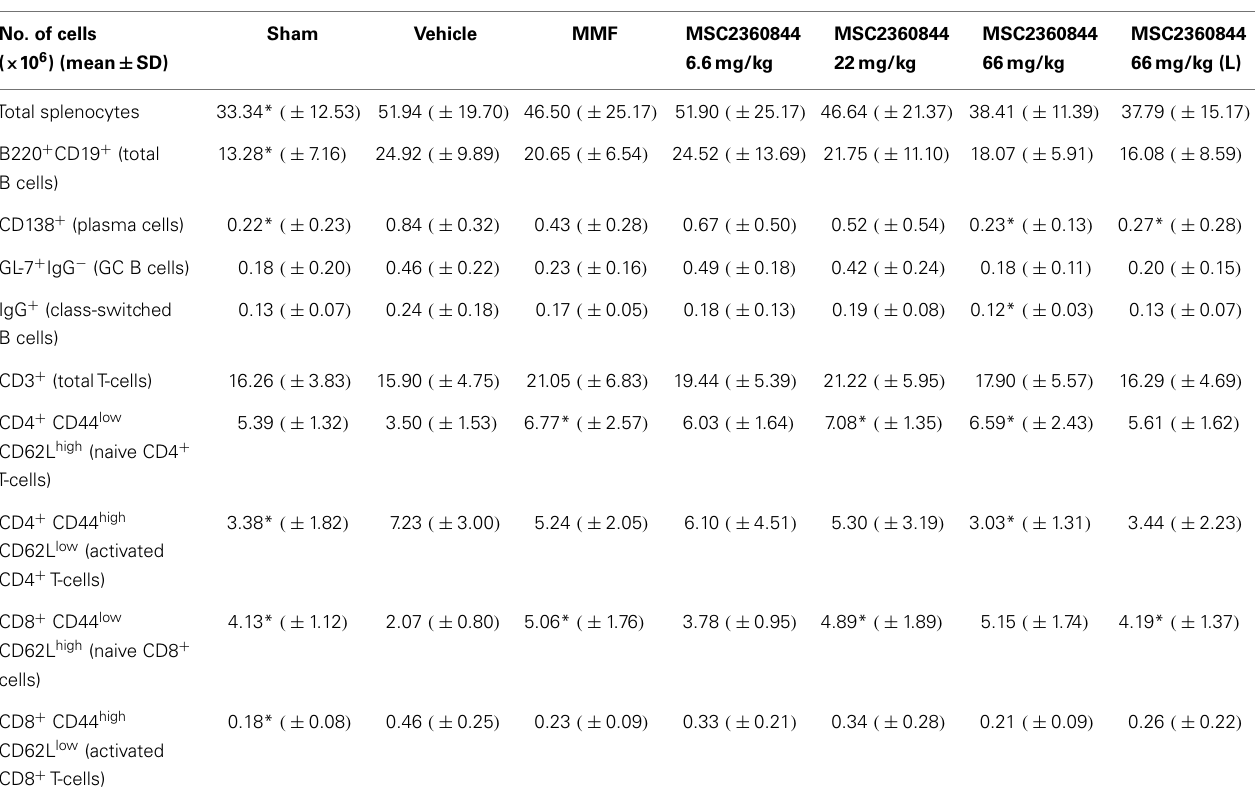
Table 2 | Numbers of lymphocyte subsets in spleen at end of the treatment